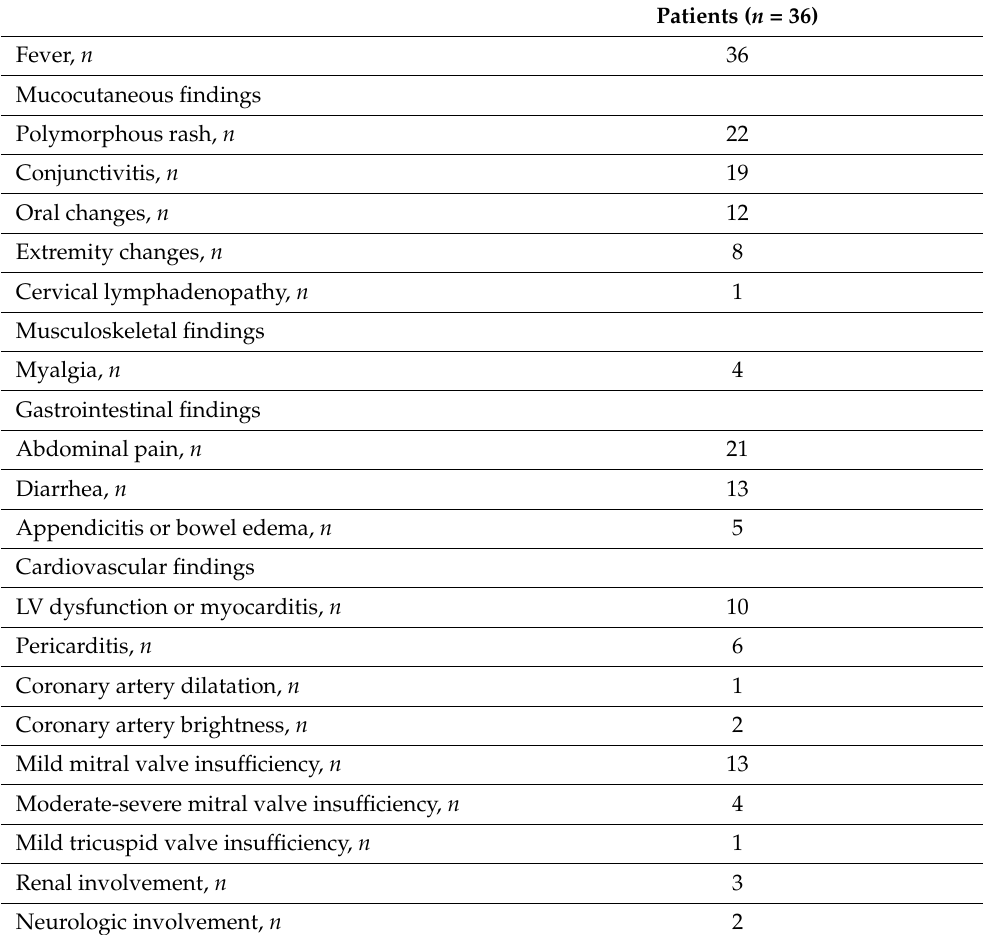
Table 1. Clinical characteristics of all patients.